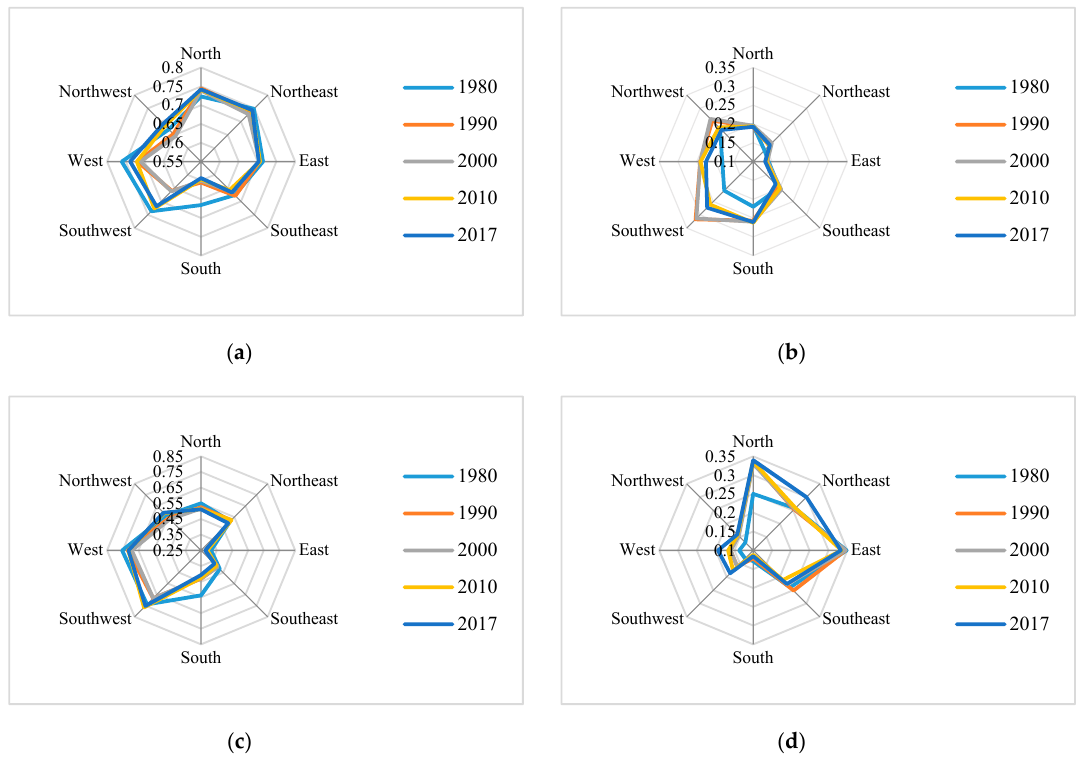
Figure 7. Landscape impact layer index changes in 8 directions ( a ). Trend of the impact index in 8 directions ( b ). Trend of the ERI index in 8 directions ( c ). Trend of the ECO index in different quadrants ( d ). Trend of the ESV index in 8 directions.